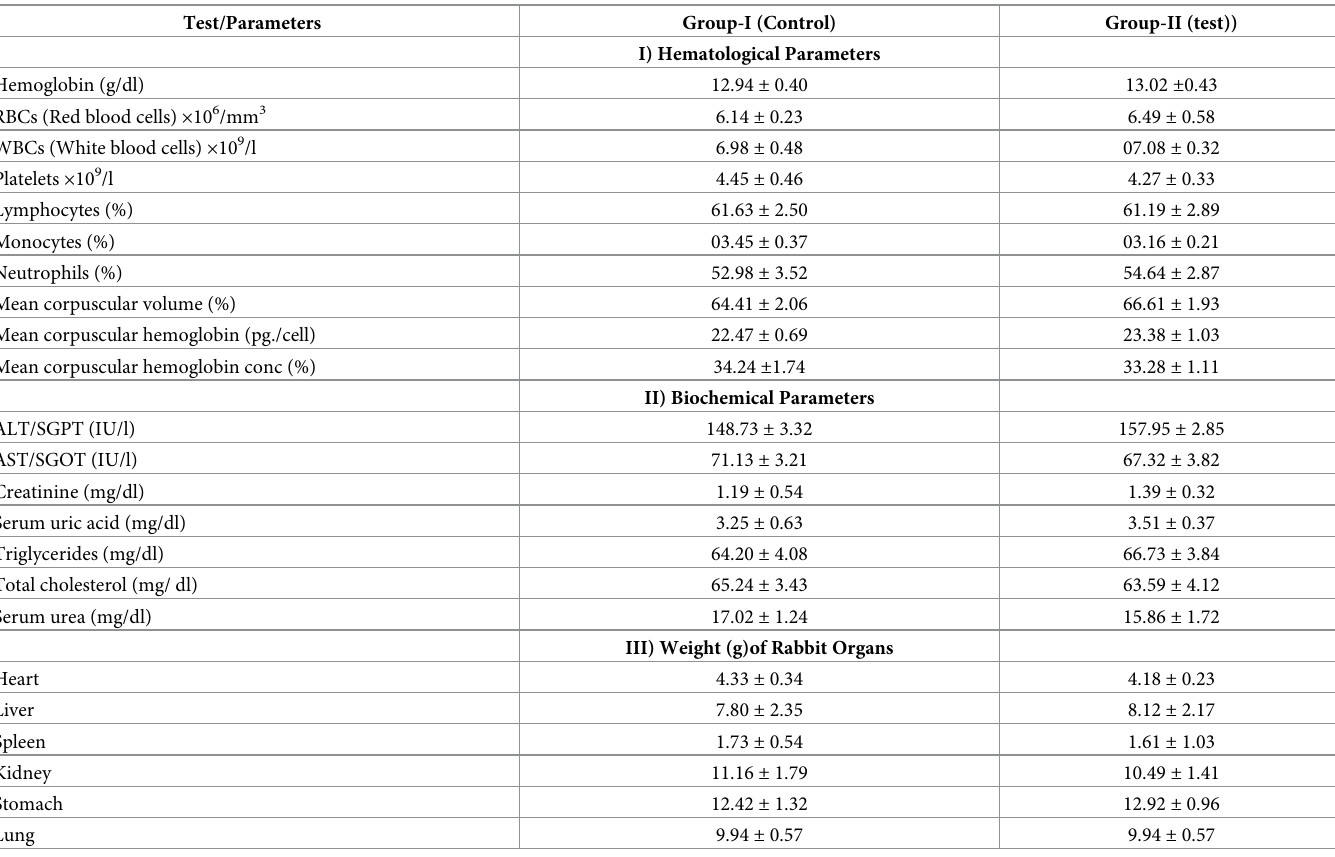
Table 6. Hematological, biochemical, and weight variation analysis of group-I (control) and group-II